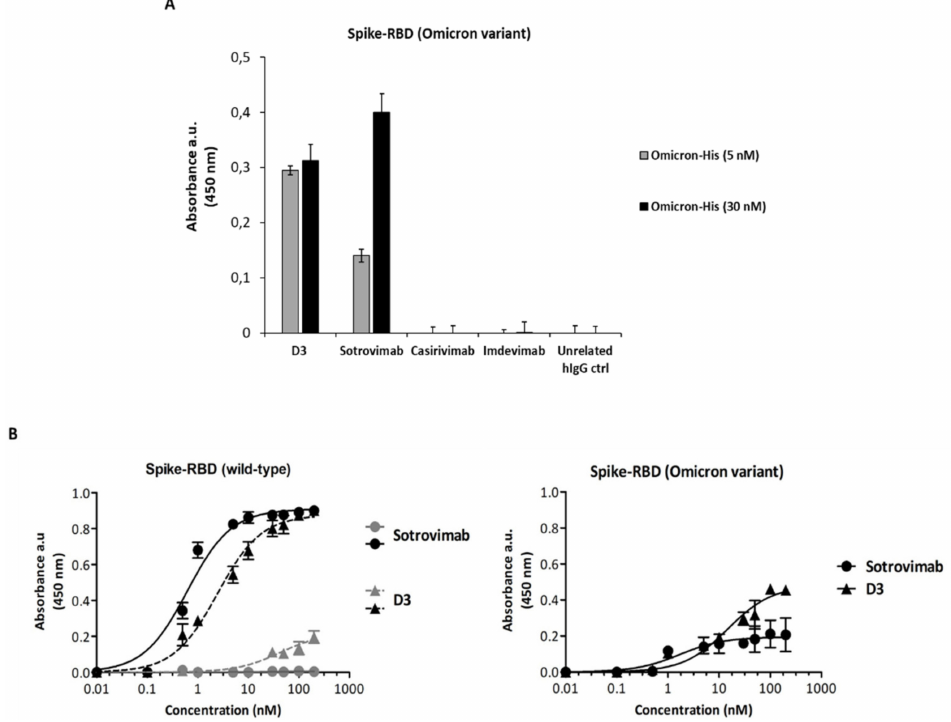
Figure 5. Binding comparison of D3 mAb to rRBD-SARS-CoV-2 Omicron variant with respect to that of Sotrovimab, Casirivimab or Imdevimab. ( A ) ACE-2/Fc recombinant protein was immobilized onto the plate and pre-incubated with rRBD-Omicron/His variant protein at concentrations of 5 nM (gray bars) or 30 nM (black bars). D3 or the other indicated mAbs were added and detected by an anti-Fab HRP-conjugated antibody for their binding to Omicron BA.1 subvariant. ( B ) D3 or Sotrovimab were incubated at increasing concentrations (0.5–200 nM) on immobilized recombinant Spike-RBD from wild-type SARS-CoV2 (left) or its Omicron variant (right). The gray curves show the binding of D3 (gray triangles) or Sotrovimab (gray circles) to the Fc domain, used as a negative control, the black curves show the binding of D3 (black triangles) or Sotrovimab (black circles) to each indicated Spike-RBD-Fc domain. Binding values were reported as the mean of at least three determinations. Error bars depicted means ±